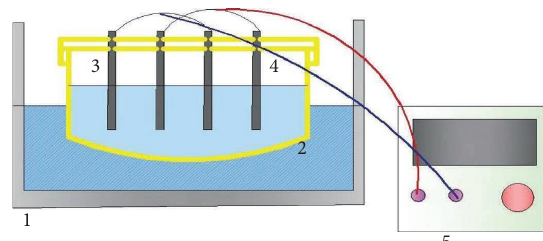
Table 1: Te variables and that levels in this